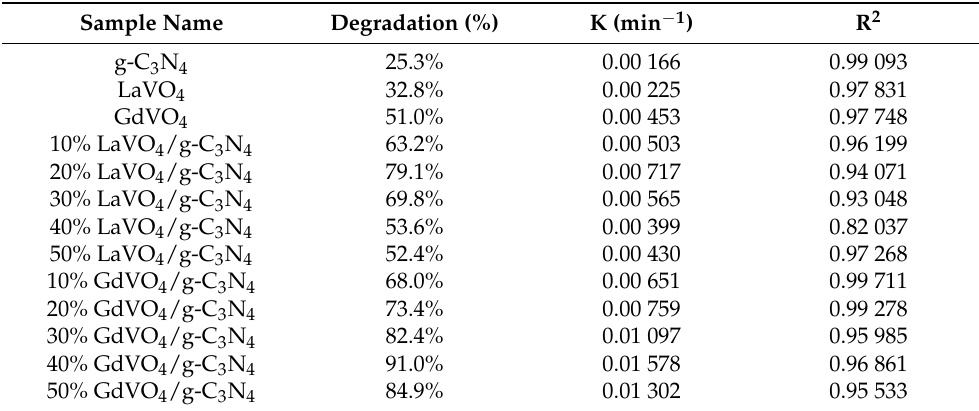
Figure 7. Photocatalytic performance of ( a ) g-C 3 N 4 , LaVO 4 , and 10–50%LaVO 4 /g-C 3 N 4 , ( b ) g-C 3 N 4 , GdVO 4 , and 10– 50%GdVO 4 /g-C 3 N 4 and kinetic curves of ( c ) g-C 3 N 4 , LaVO 4 , and 10–50%LaVO 4 /g-C 3 N 4 , ( d ) g-C 3 N 4 , GdVO 4 , and 10–50%GdVO 4 /g-C 3 N 4. Table 1. Photocatalytic results of all samples.